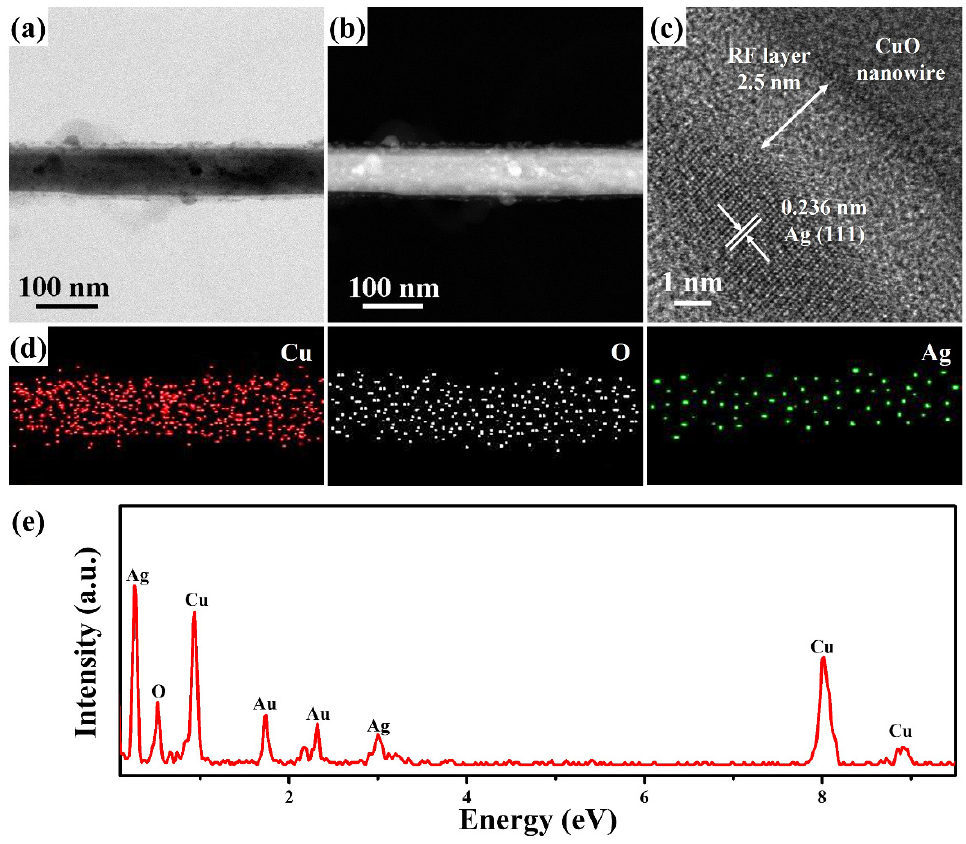
Figure 5. The ( a ) FETEM, ( b ) HAADF, ( c ) HRTEM, ( d ) EDS mapping images, and ( e ) EDS spectrum of a CuO@Ag nanowire fabricated at a resorcinol weight of 16.37 mg and a AgNO 3 concentration of 0.45 mM.